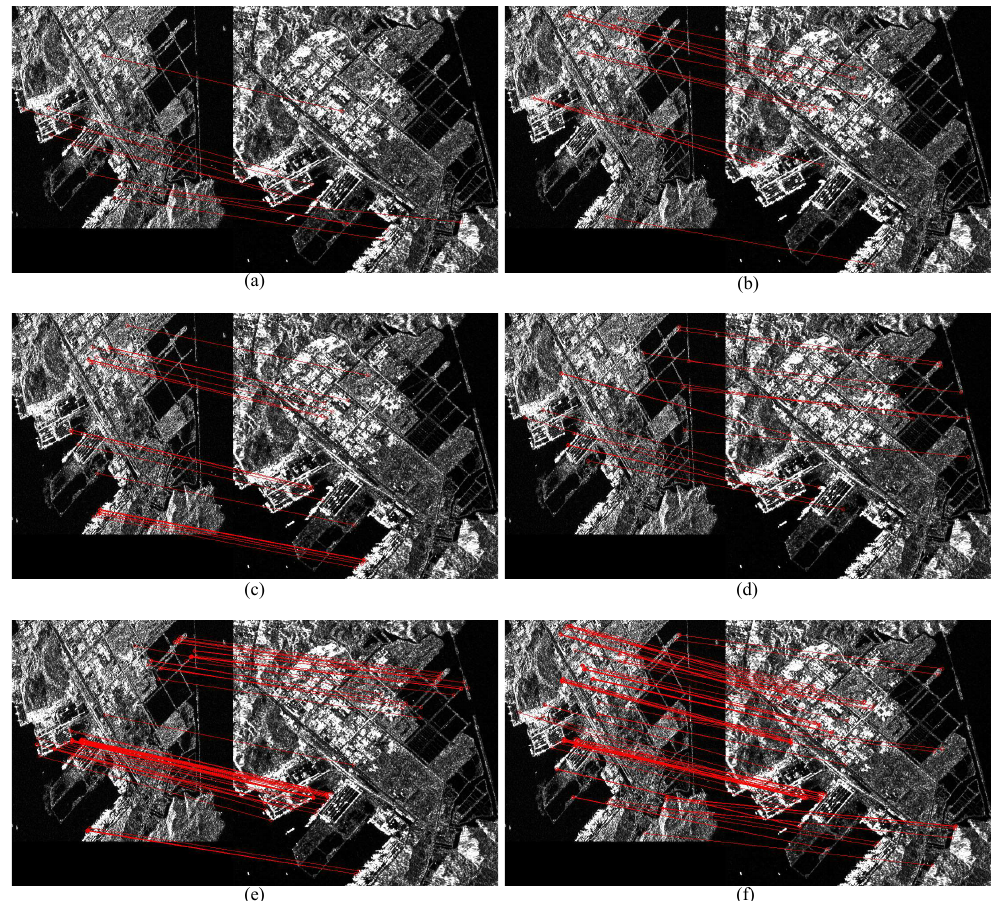
Figure 20. The feature descriptor matching results with different keypoint detectors. ( a ) DoG.